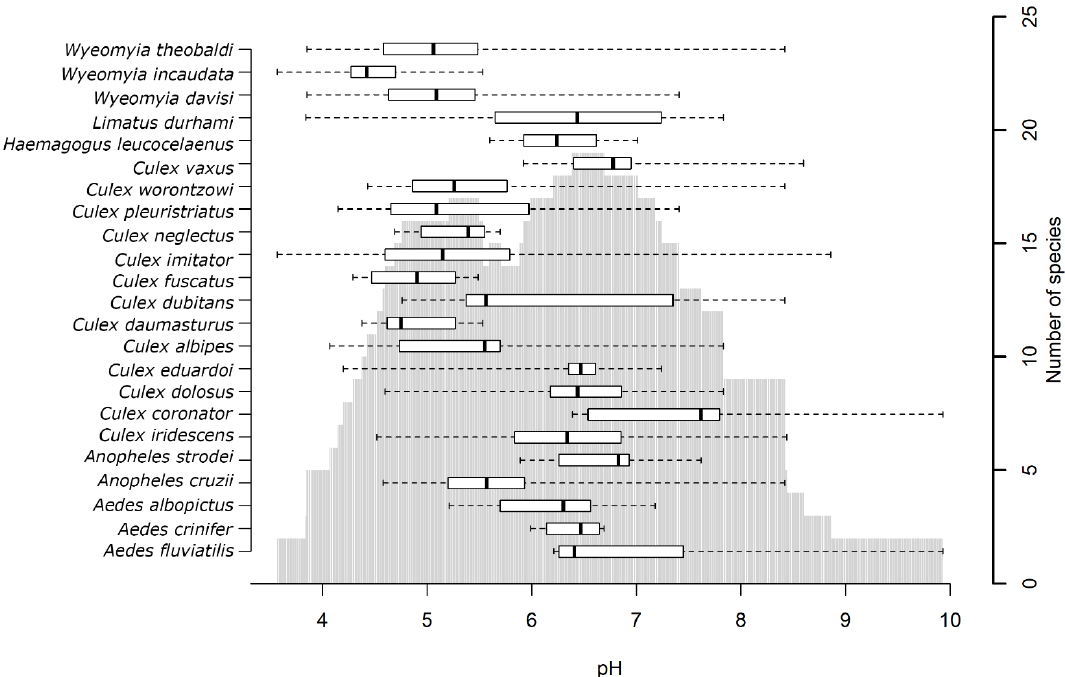
Figure 2. Variation in the number of species and specimens with pH of water from breeding sites. The boxplot (based on medians) and whiskers represent the range of pH values within which each species was found. The box represents the pH interval within which the species was observed most frequently. The vertical gray bars represent the number of species observed for the corresponding range of pHs.